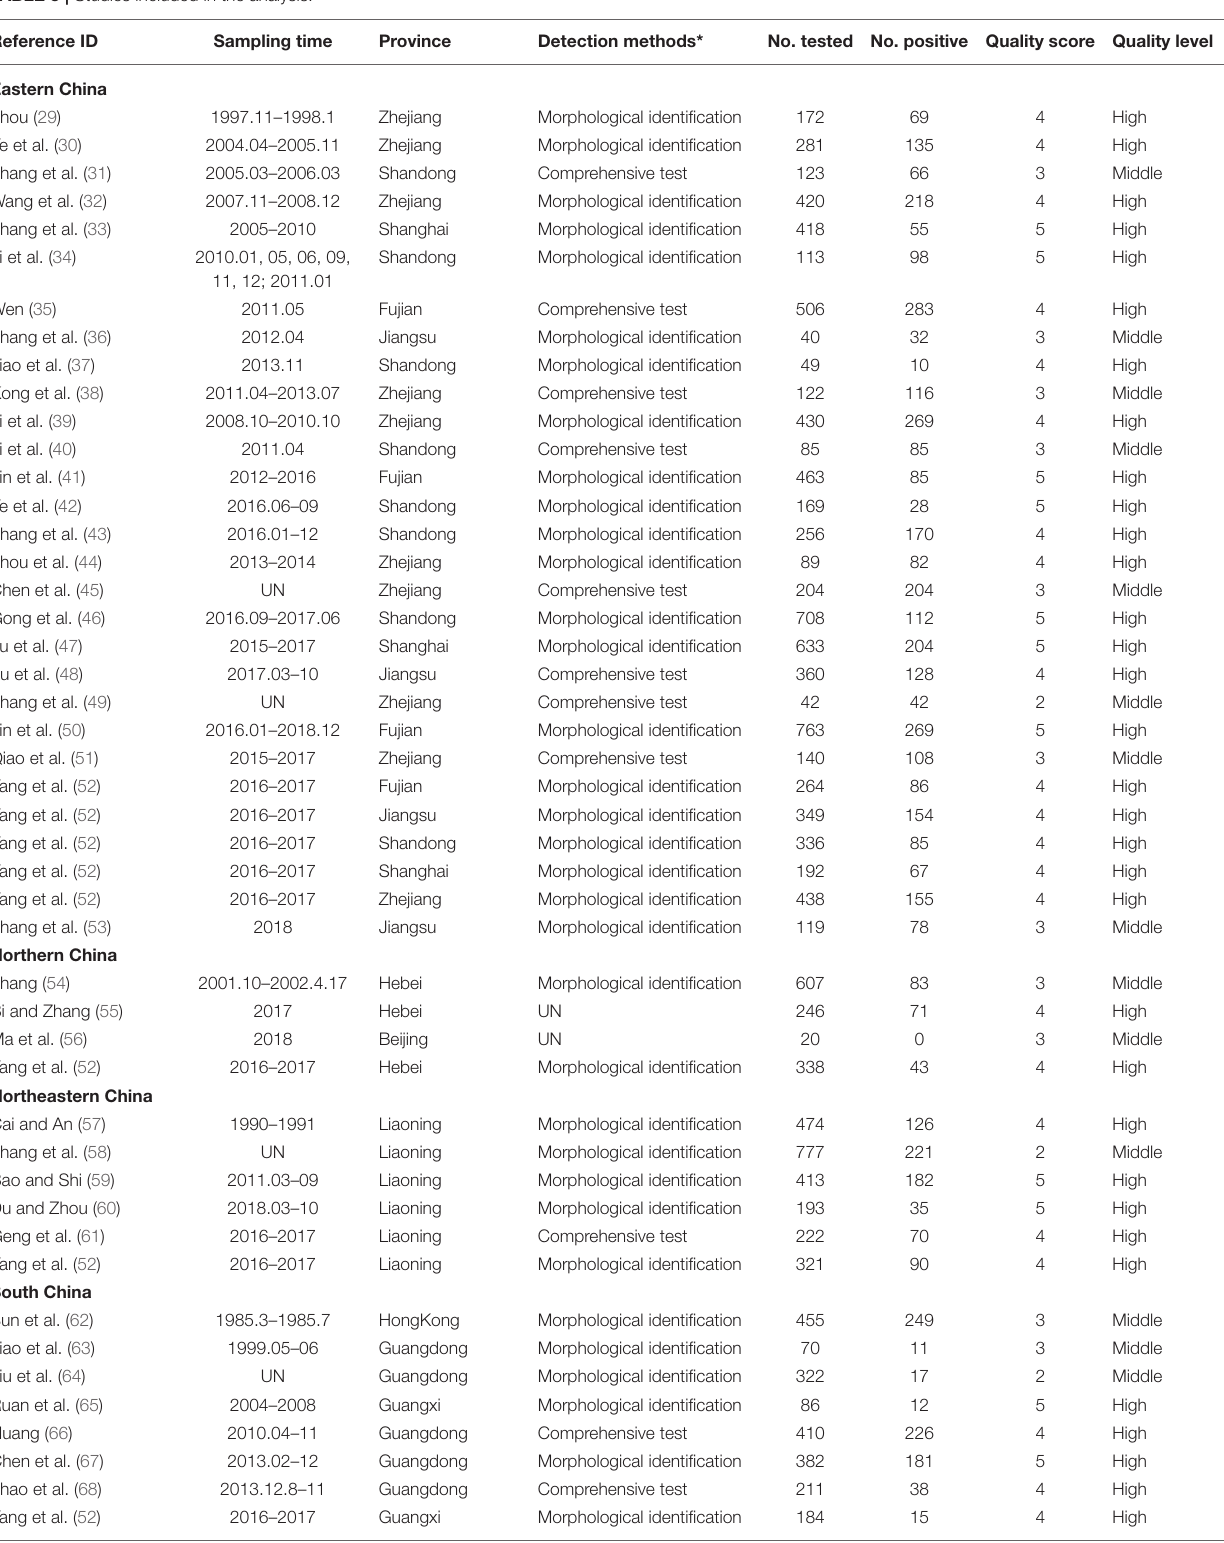
TABLE 3 | Studies included in the